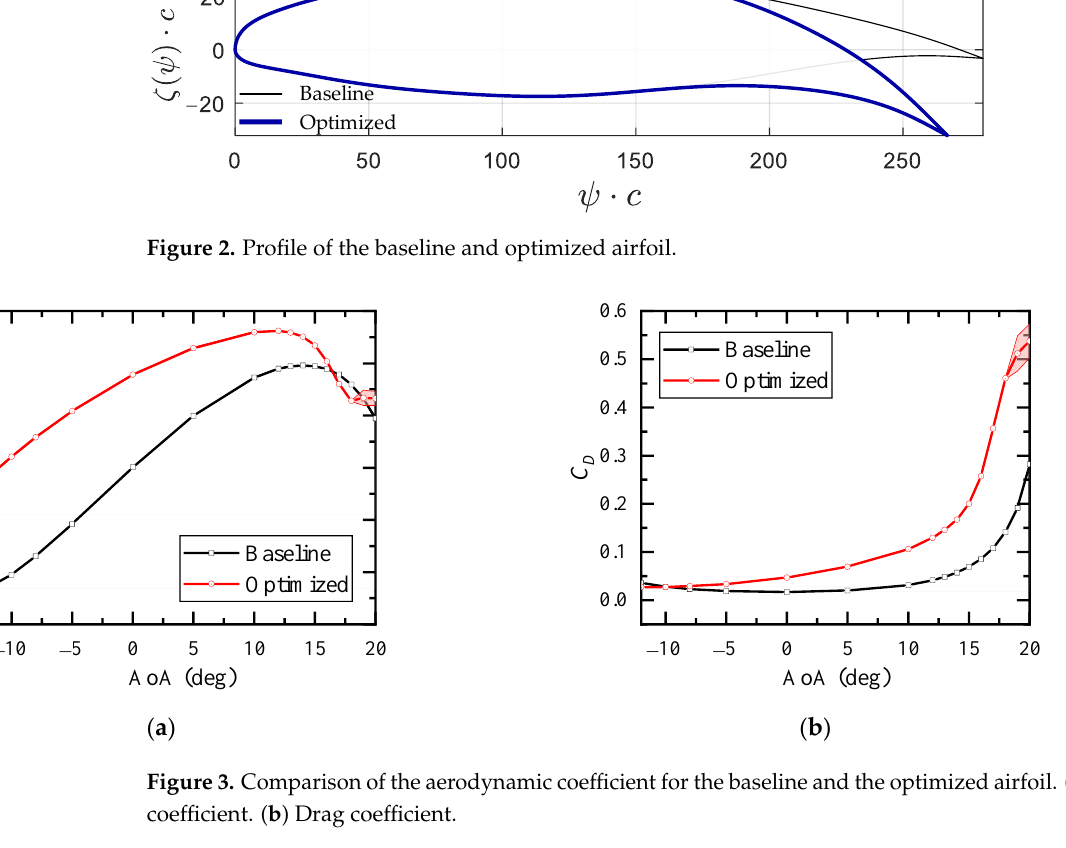
Figure 4. Trailing edge deformation for optimized structure (actuation input is limited within ±60°).